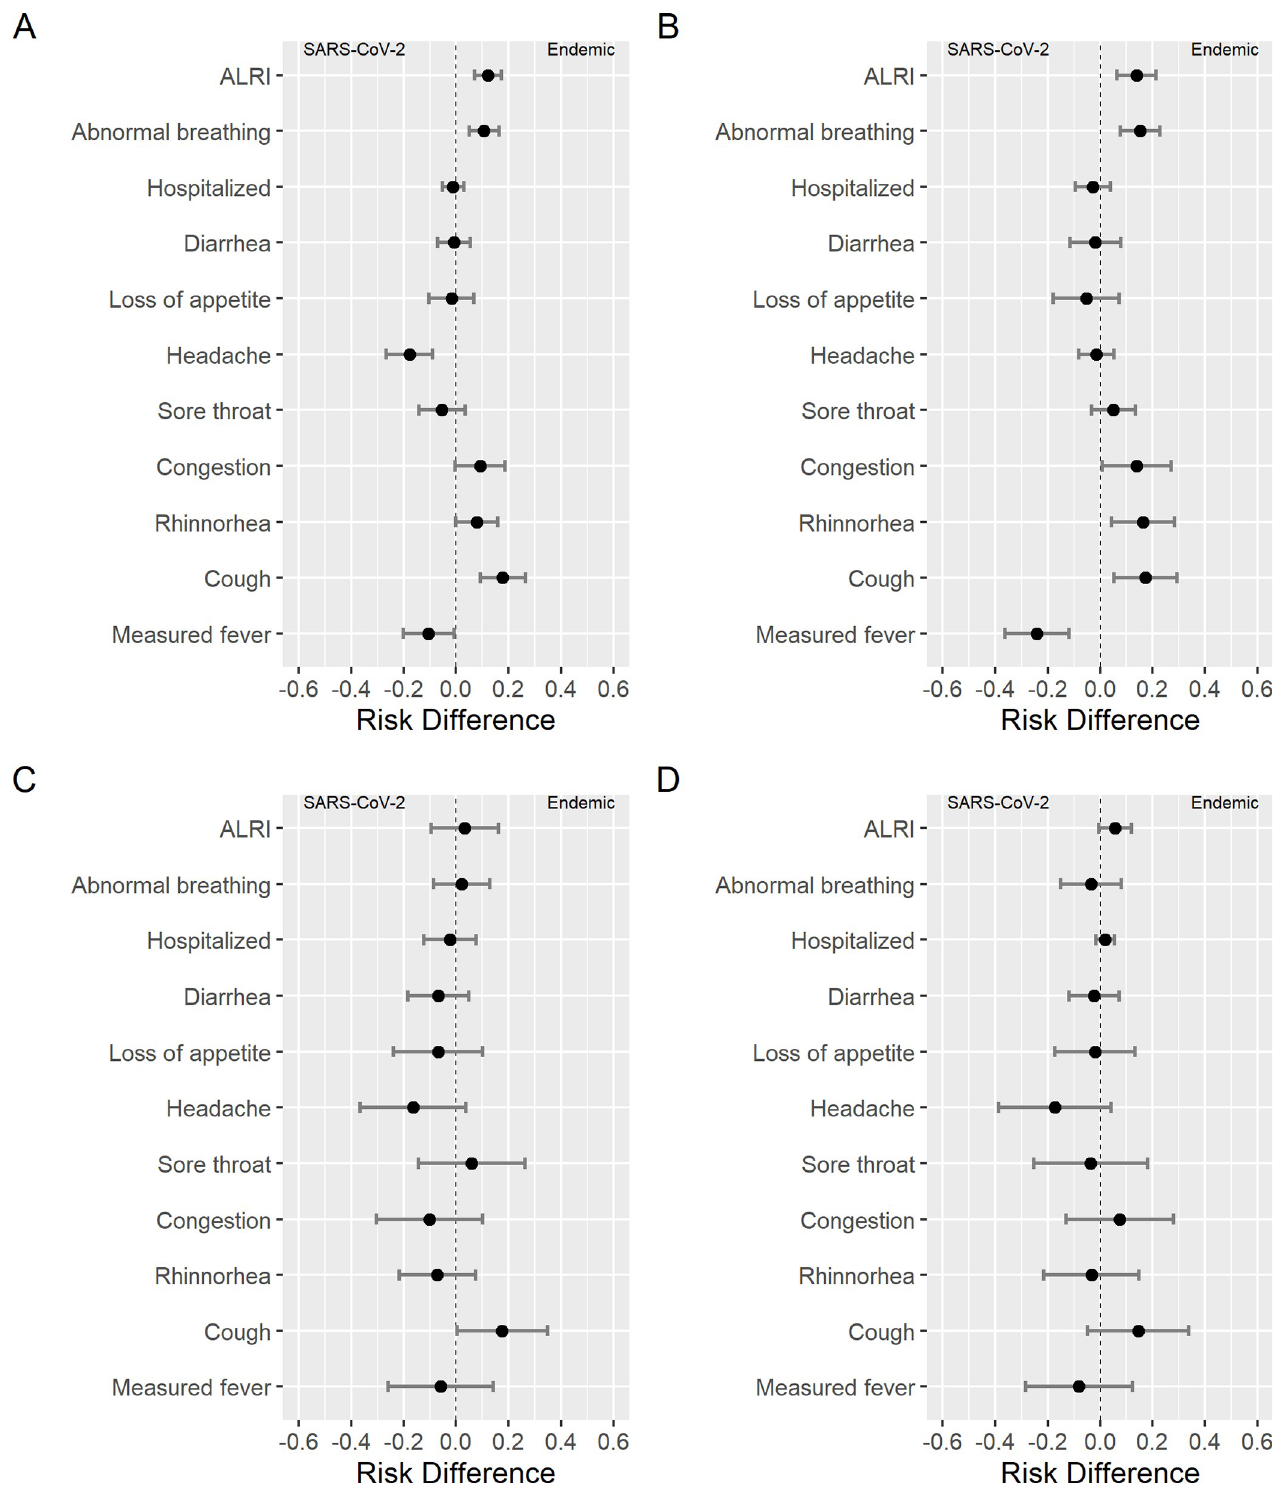
Fig 1. Symptom risk difference between endemic HCoVs and SARS-CoV-2. A: All participants. B: Ages 0–4 years. C: Ages 5–9 years. D Ages: 10–14 years.